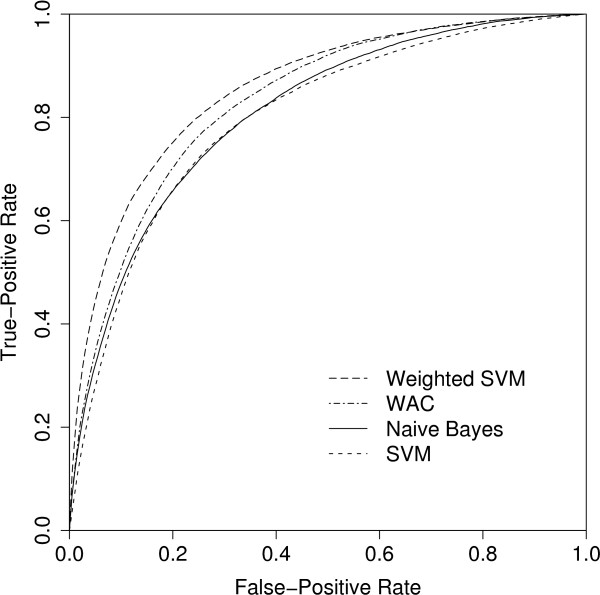
Final validation: Averaged ROC curves of the classifiers. The averaged ROC curves were obtained from the folds of the 5 × 2 cross-validation using the vertical averaging method described by Fawcett [41].